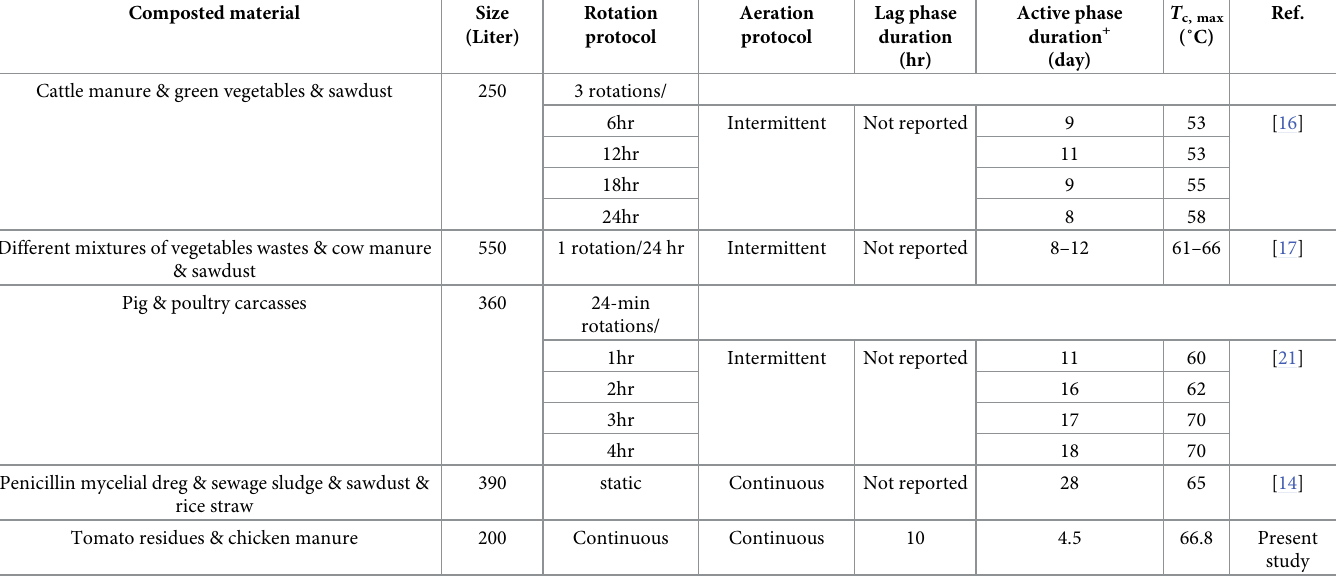
Table 5. Results of the proposed method compared to results of other composting methods. Composted